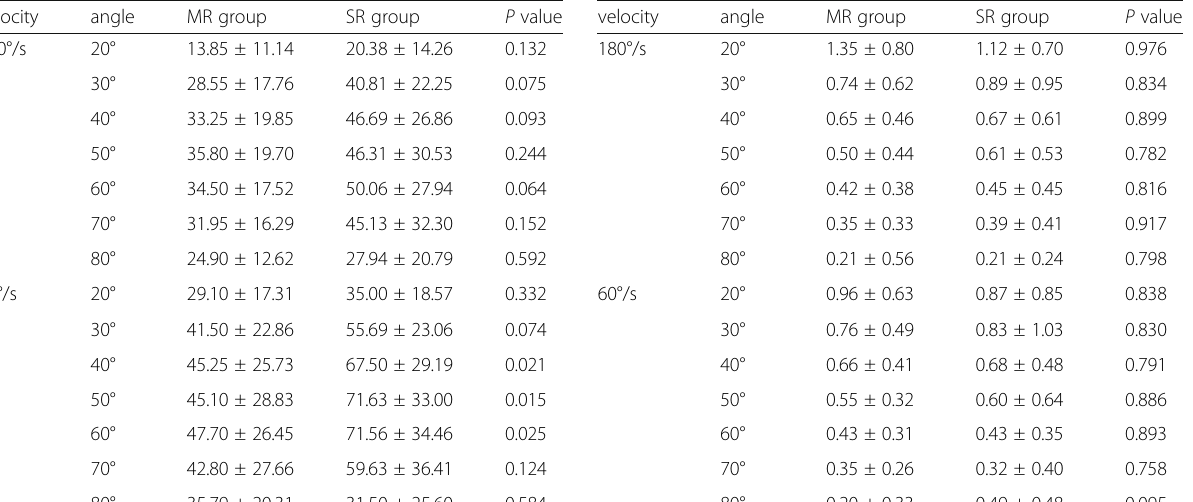
Table 6 Angle-specific H/Q ratio (mean ± SD) at 180°/s and